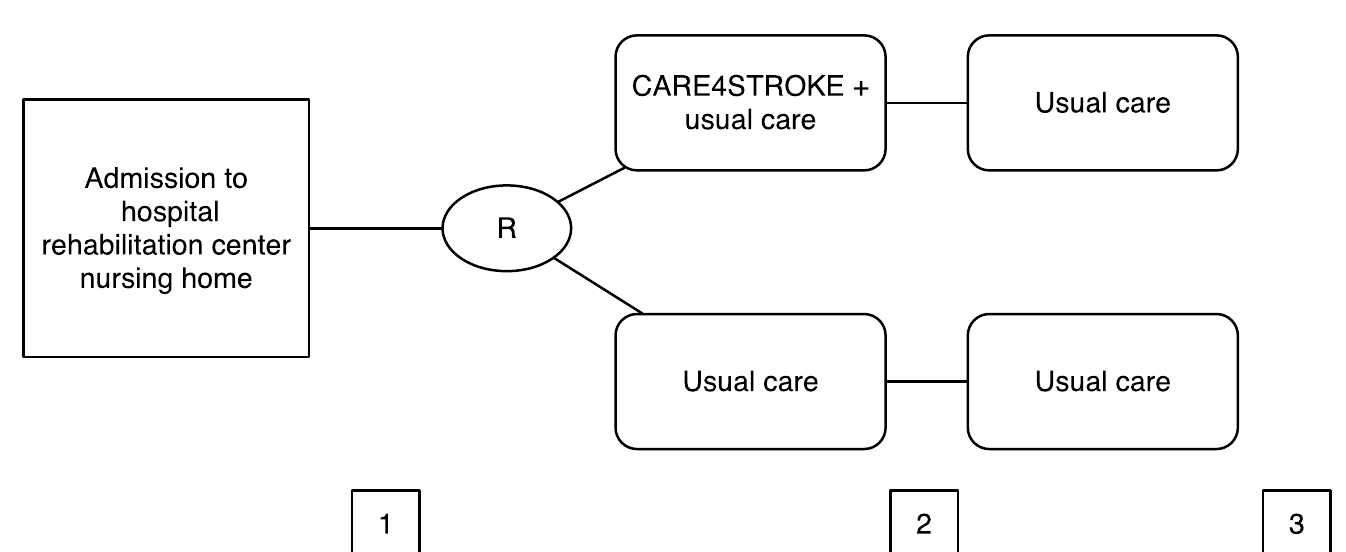
Fig 1. Study design. R = Randomization. 1 = Measurement 1, baseline, before start of the intervention. 2 = Measurement 2, end of intervention (8 weeks post randomization). 3 = Measurement 3, follow up (12 weeks post